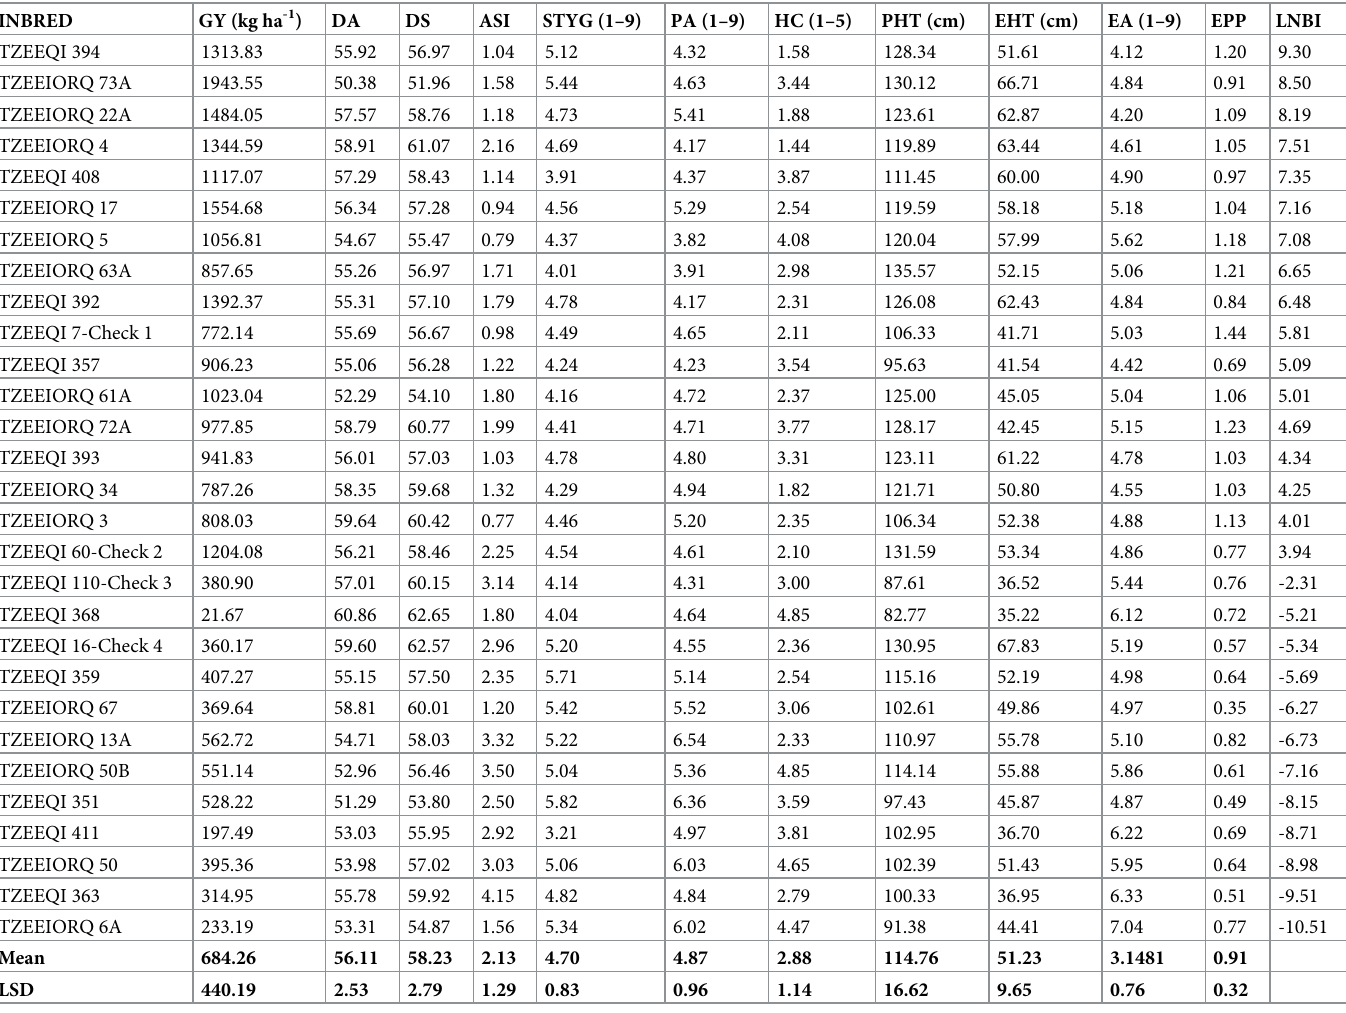
Table 2. Grain yield and other traits of 25 (top 15 and worst 10) inbred lines along with four checks under LN stress